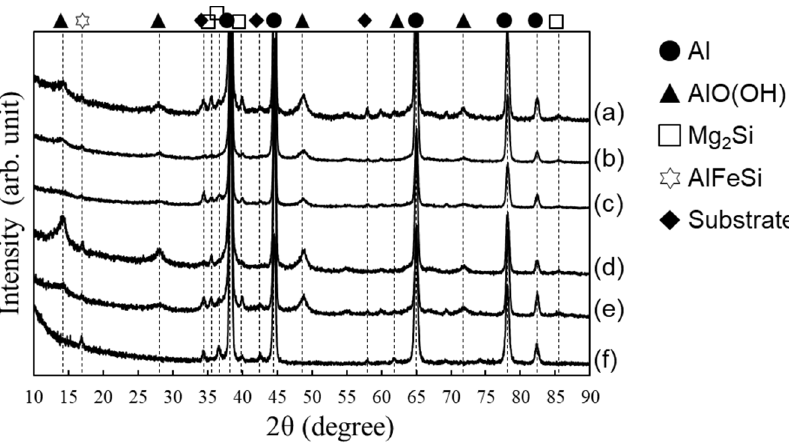
Figure 5. GAXRD profiles of specimens subjected to steam coating at ( a ) 160 °C for 1 h; ( b ) 170 °C for 0.5 h; ( c ) 170 °C for 1 h; ( d ) 180 °C for 0.5 h; ( e ) 180 °C for 1 h; and ( f ) as ‐ received specimen as a reference.